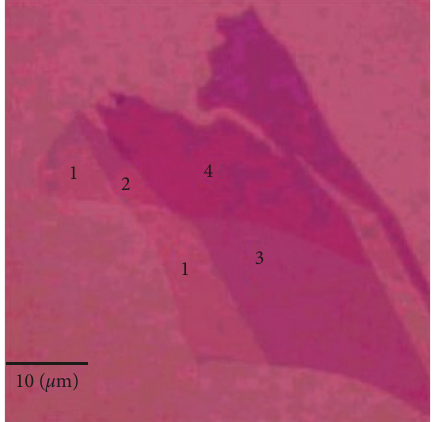
Figure 7: Multilayer graphene optical image